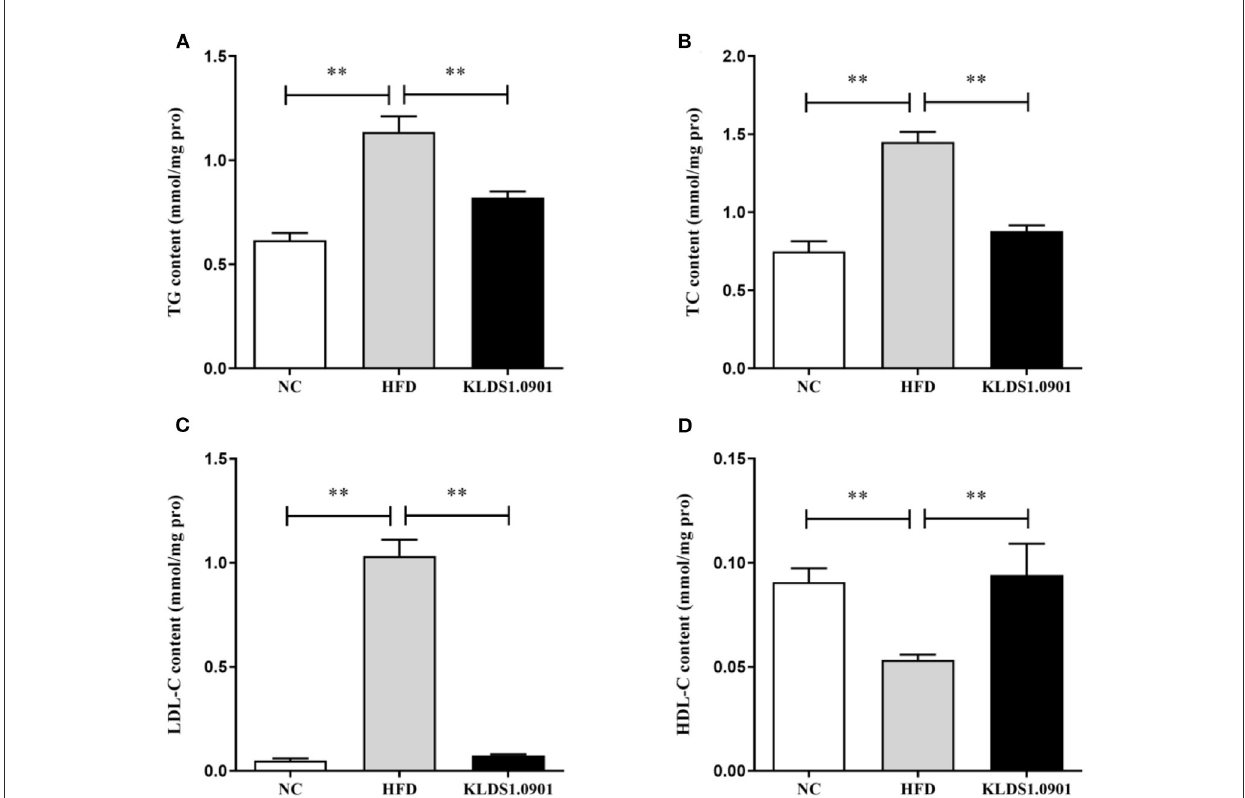
FIGURE2 Effects of L. acidophilus KLDS1.0901 administration on lipid accumulation in HFD-fed mice. NC, normal control group; HFD, high-fat diet group; and KLDS1.0901, L. acidophilus KLDS1.0901 group. (A) Hepatic triglyceride (TG) level; (B) hepatic total cholesterol (TC) level; (C) hepatic low-density lipoprotein cholesterol (HDL-C) level; and (D) hepatic high-density lipoprotein cholesterol (LDL-C) level. Values are expressed as mean ± SD ( n = 8). ** p < 0.01 indicated that there was a significant difference when compared with the HFD